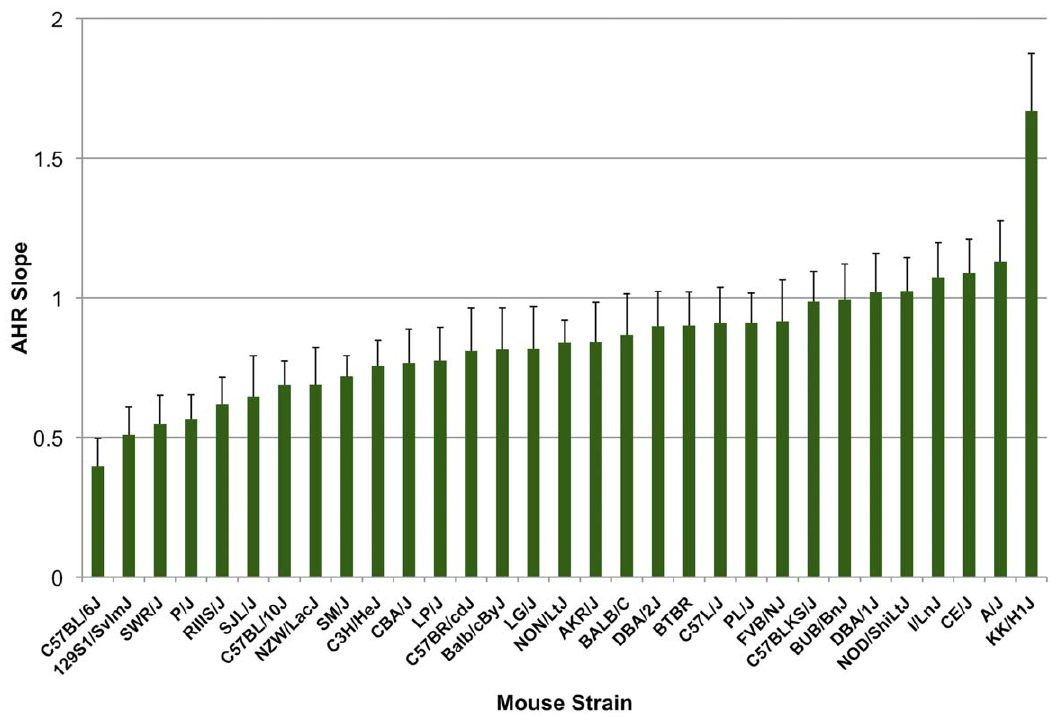
Figure 2. Baseline AHR slope phenotype distribution among 31 mouse strains. The AHR slope, displayed along the y-axis, was computed as the slope of the resistance measures vs. log-transformed methacholine concentrations for each mouse strain. Names for each mouse strain are displayed along the x-axis.